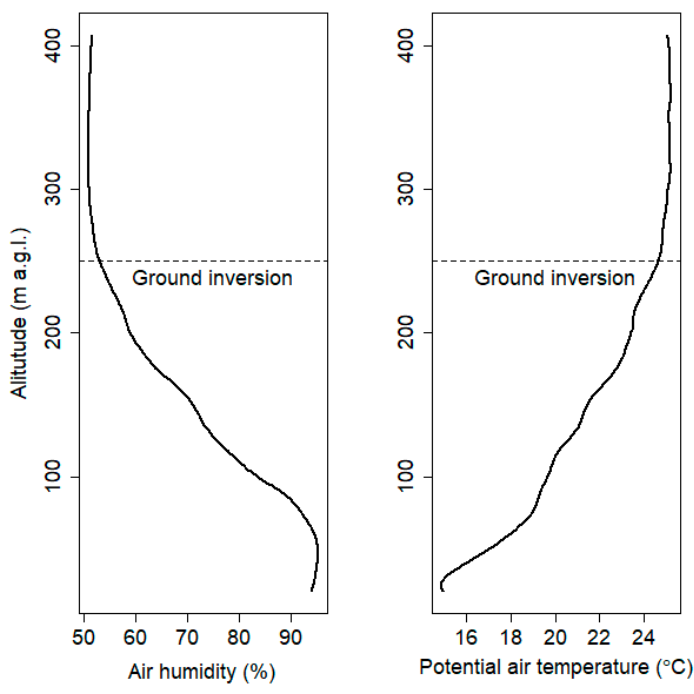
Figure 8. Ground inversion layer height at sixth flight (18 September